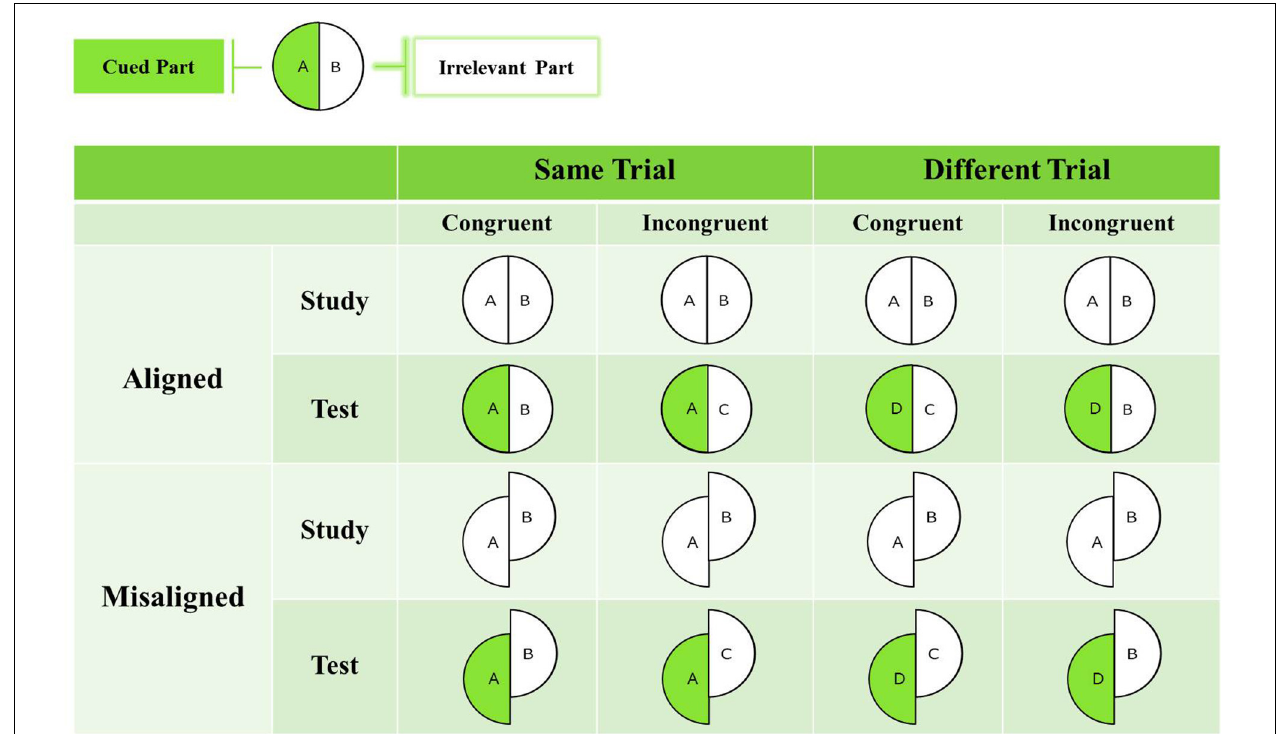
FIGURE 1 | Schematic diagram depicting the left-right composite paradigm. In this example, the cued part is on the left (with a green/shaded background) and the irrelevant part is on the right (with a white background). The format of the study and test faces can be either both aligned or both misaligned. Participants are instructed to make a same/different judgment